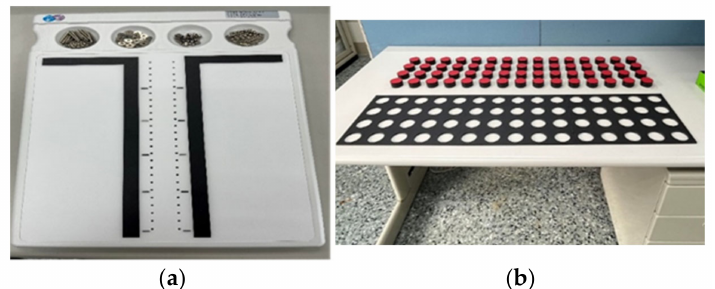
Figure 1. Manual dexterity test kits. ( a ) Purdue Pegboard Test (PPT); ( b ) Minnesota Dexterity Test (MDT).